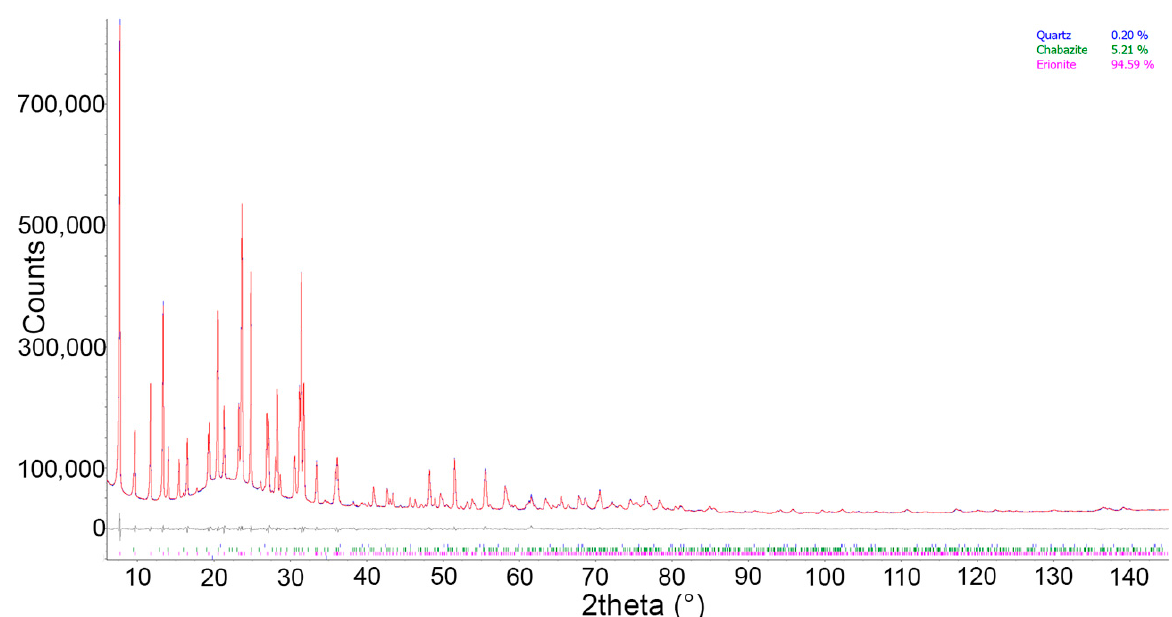
Figure 1. Conventional Rietveld plots of the sample incubated for 24 h. Blue: experimental, red: calculated, gray: difference. Vertical bars refer to the calculated positions of the Bragg reflections of (from above to below) quartz, chabazite and erionite. Table 1. Miscellaneous data of the mixed Pawley–Rietveld refinements. a Reference data of Pacella et al. [35]. - refers to data not calculated.